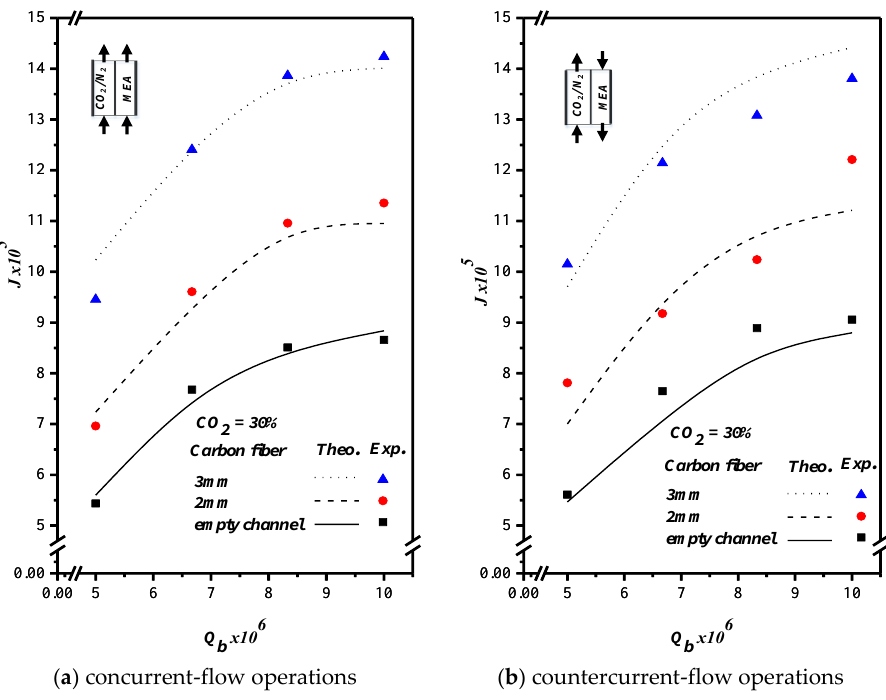
Figure 12. E ff ects of the MEA flow rate and carbon-fiber spacers’ width on CO 2 absorption flux. Figure 12. Effects of the MEA flow rate and carbon-fiber spacers ’ width on CO 2 absorption flux. ( a ) ( a ) concurrent-flow operations; ( b ) countercurrent-flow operations. concurrent-flow operations; ( b ) countercurrent-flow operations. Table 1. E ff ects of operating condition and spacers’ width on γ m for concurrent-flow operations.